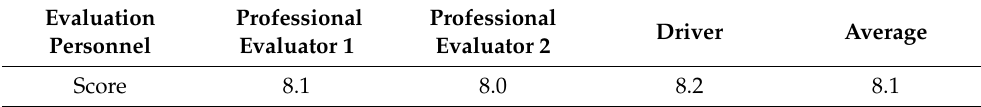
Table 7. Subjective evaluation scoring results